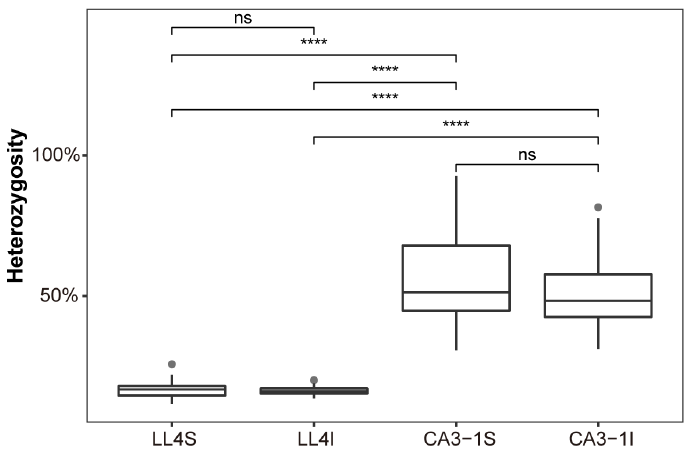
Figure 9. The heterozygosity of SNP and INDEL. LL4S represents the SNPs of Longli-4. LL4I represents the INDELs of Longli-4. CA3-1S represents the SNPs of CA3-1. CA3-1I represents the INDELs of CA3-1. ns, not significant, ****, p < 10 − 6.